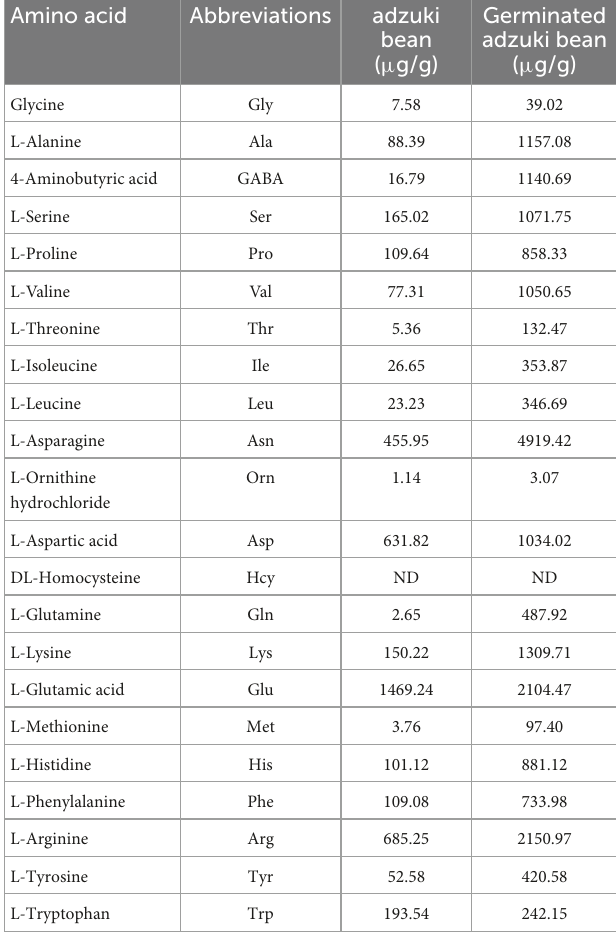
TABLE 4 Amino acid composition of adzuki beans before and after